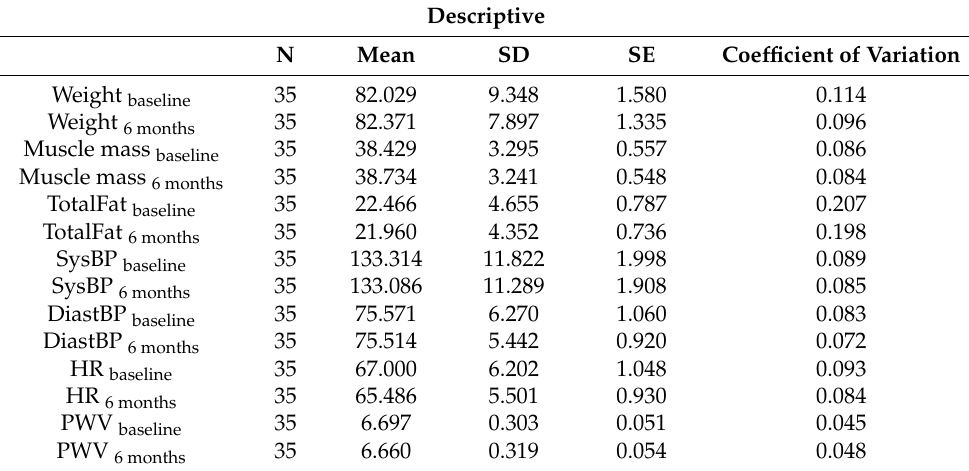
Table 2. Descriptive characteristics of patients in the NAG at baseline and six months.